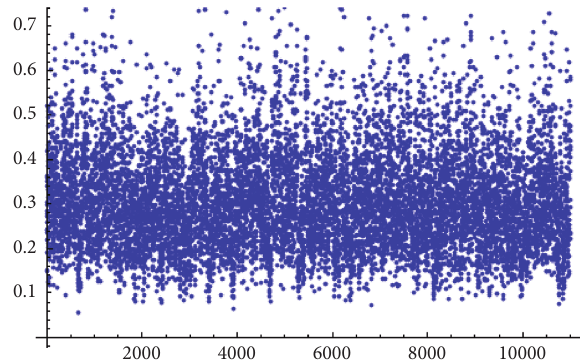
Figure 5: Simulation number of θ